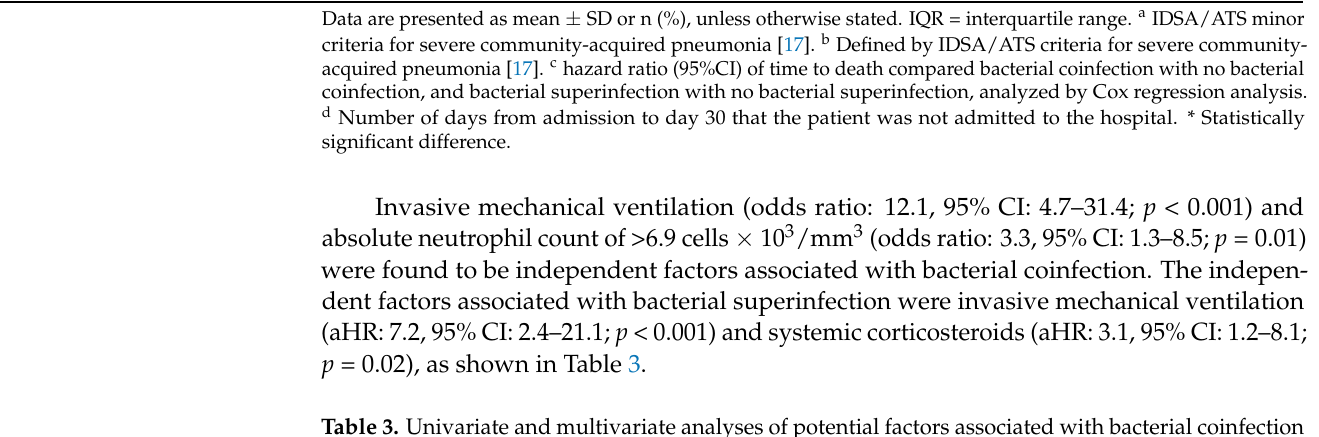
Table 3. Univariate and multivariate analyses of potential factors associated with bacterial coinfection and bacterial